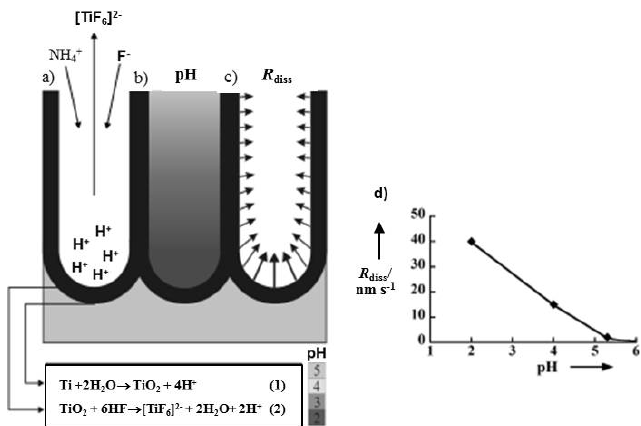
Table 2. Summary of the nanotube dimensions under different voltage and pH conditions and their maximum resistance variation to 1,000 ppm H anodization time was 17 h for all samples. Reprinted from [8] with permission.